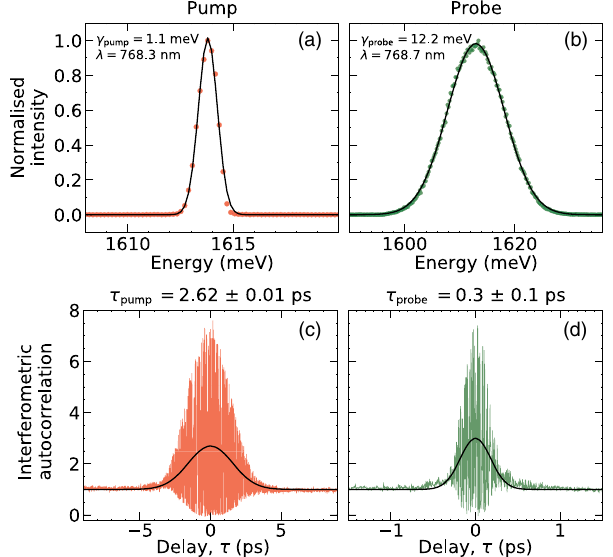
FIG. 7. (a),(b) A typical spectrum of the pump and probe pulse, respectively, after traveling through the optical fibers. (c),(d) In- terferometric autocorrelation signal of the pump and probe, respectively. Black lines are Gaussian fits to the data from which the linewidths (a),(b) and pulse duration (c),(d) are